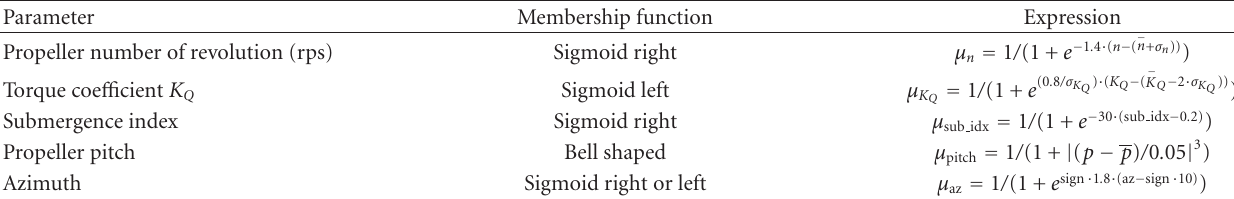
Table 2: Membership function